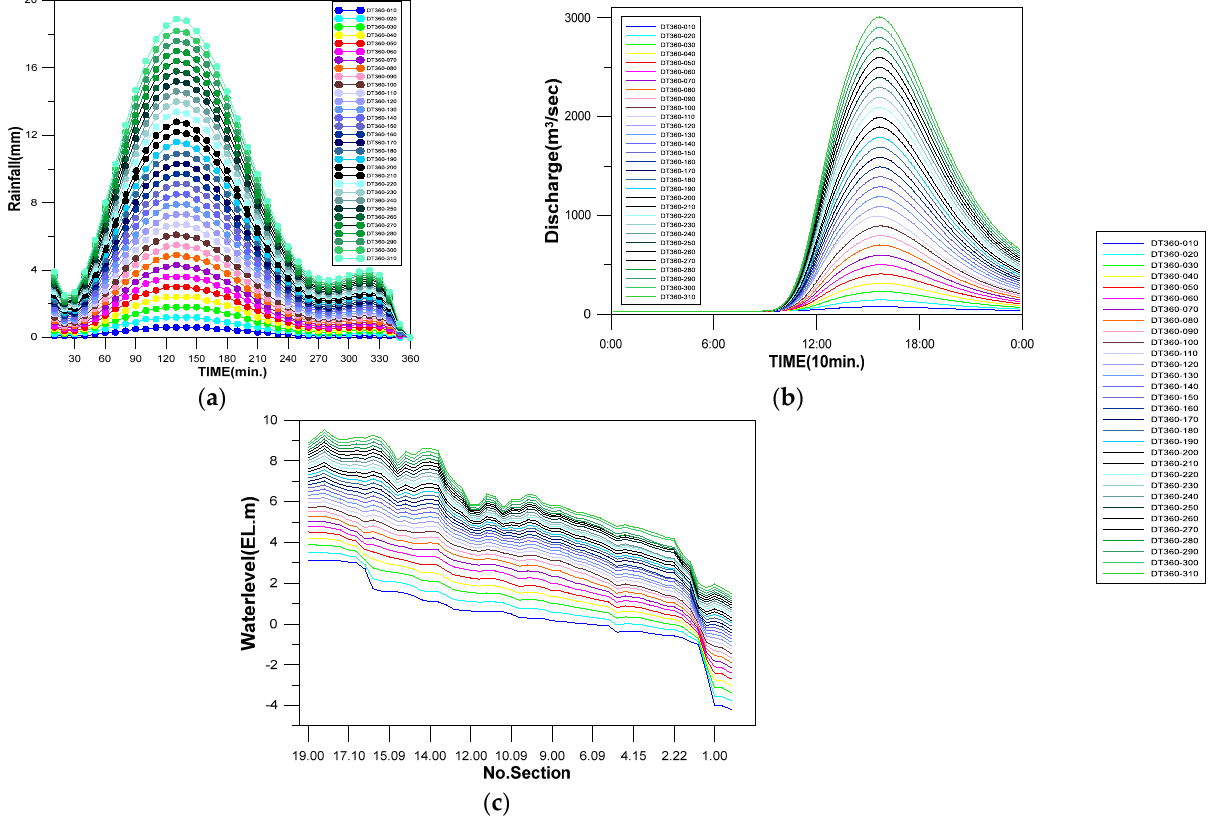
Figure 6. Simulated discharge and water level using rainfall scenarios for 360 min duration: ( a ) Rainfall scenarios; ( b ) Simulated discharge scenarios; ( c ) Simulated water level scenarios.